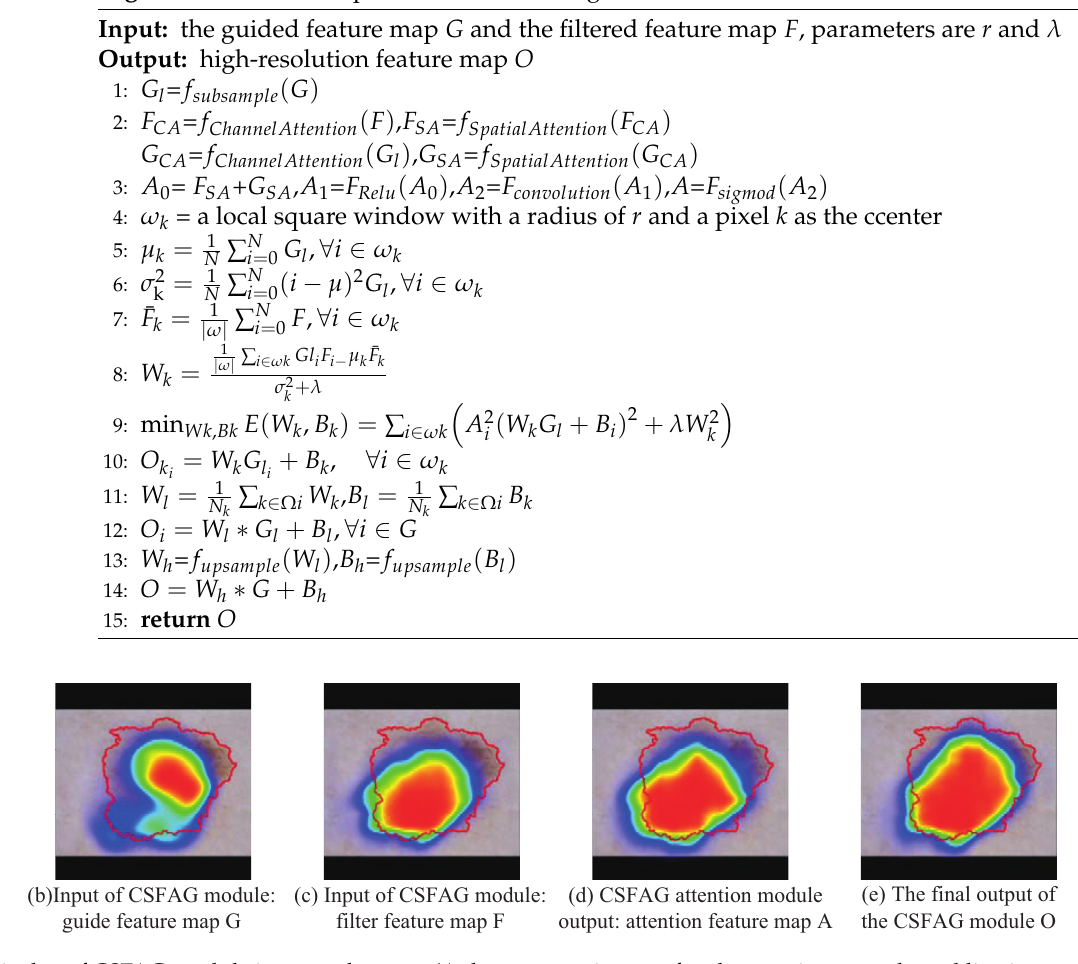
Figure 4. Visual display of CSFAG module input and output (A dermoscopy image of melanoma is a case, the red line is ground